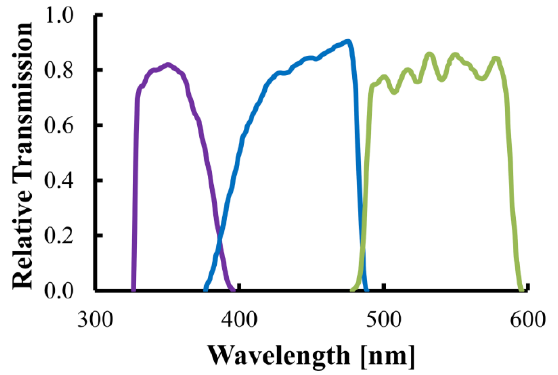
F IGURE 3. Relative transmission of the three colour filters (Baader). Violet: UV-filter transmits UV light only. Blue: Blue filter that only transmits blue light. Green: Green filter that only transmits light of the green part of the spectrum (changed according to Schmitt K., personal communication, 21. September 2015).